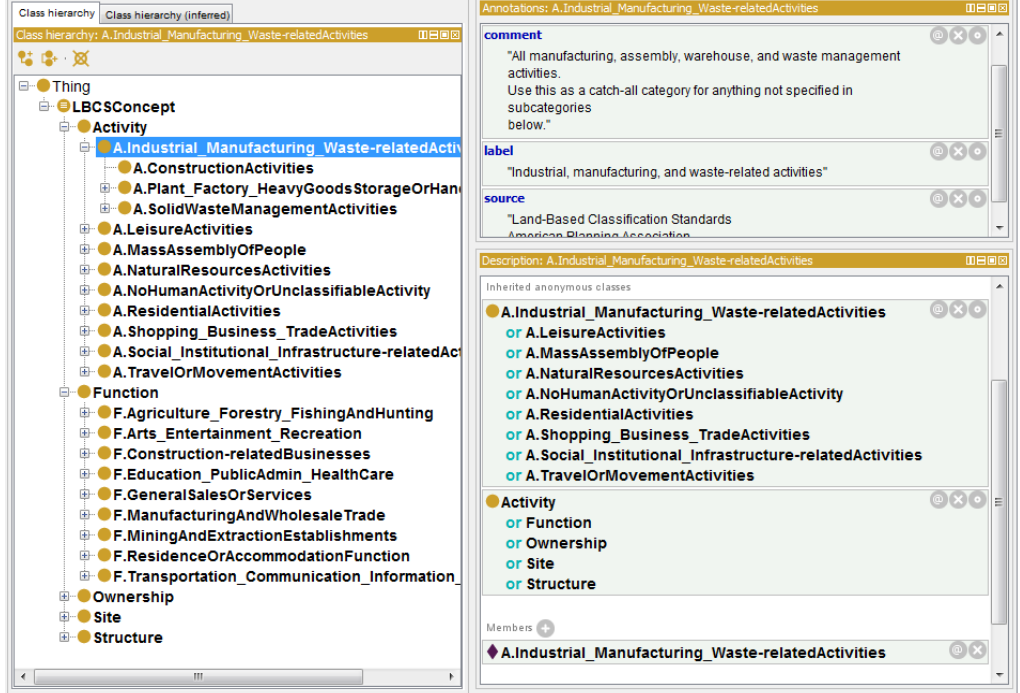
Figure 1. The LBCS class hierarchy. The LBCS concept seen as a class with three annotation properties for registering the full name, description and source. Each class has an individual with the same